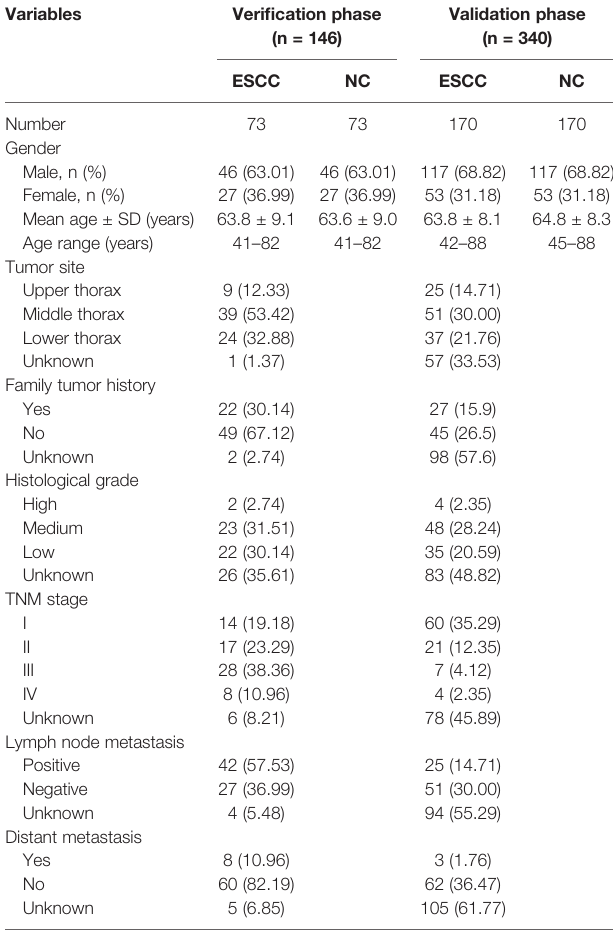
TABLE 1 | Characteristics of study